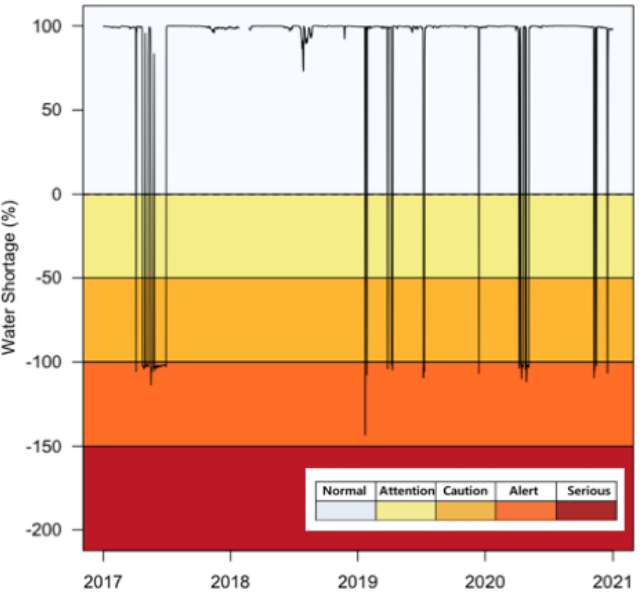
Figure 6. Water shortage and five-stage drought conditions for the Hyunri water intake plant (HWIP).